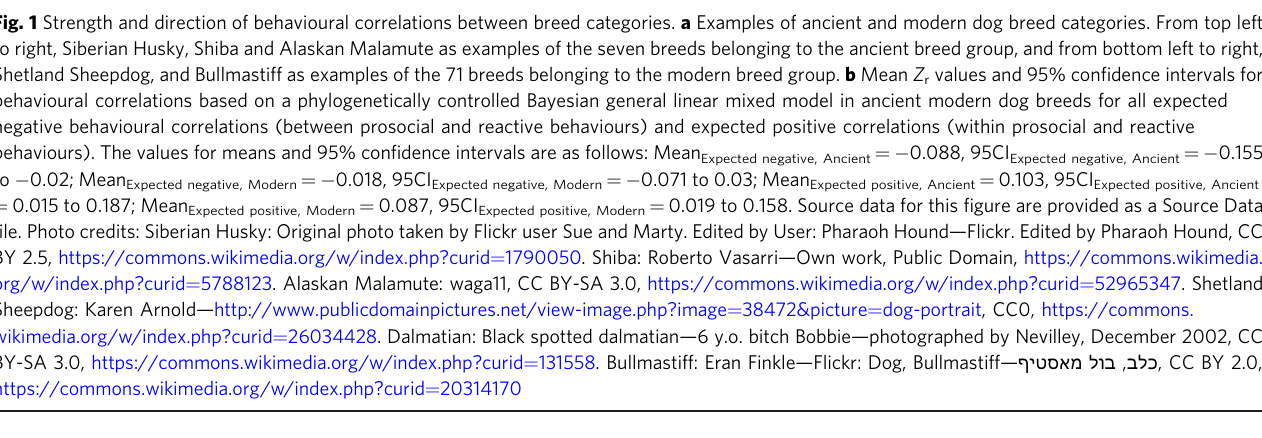
Table 1 Comparison of direction-speci fi c effect sizes between breed categories